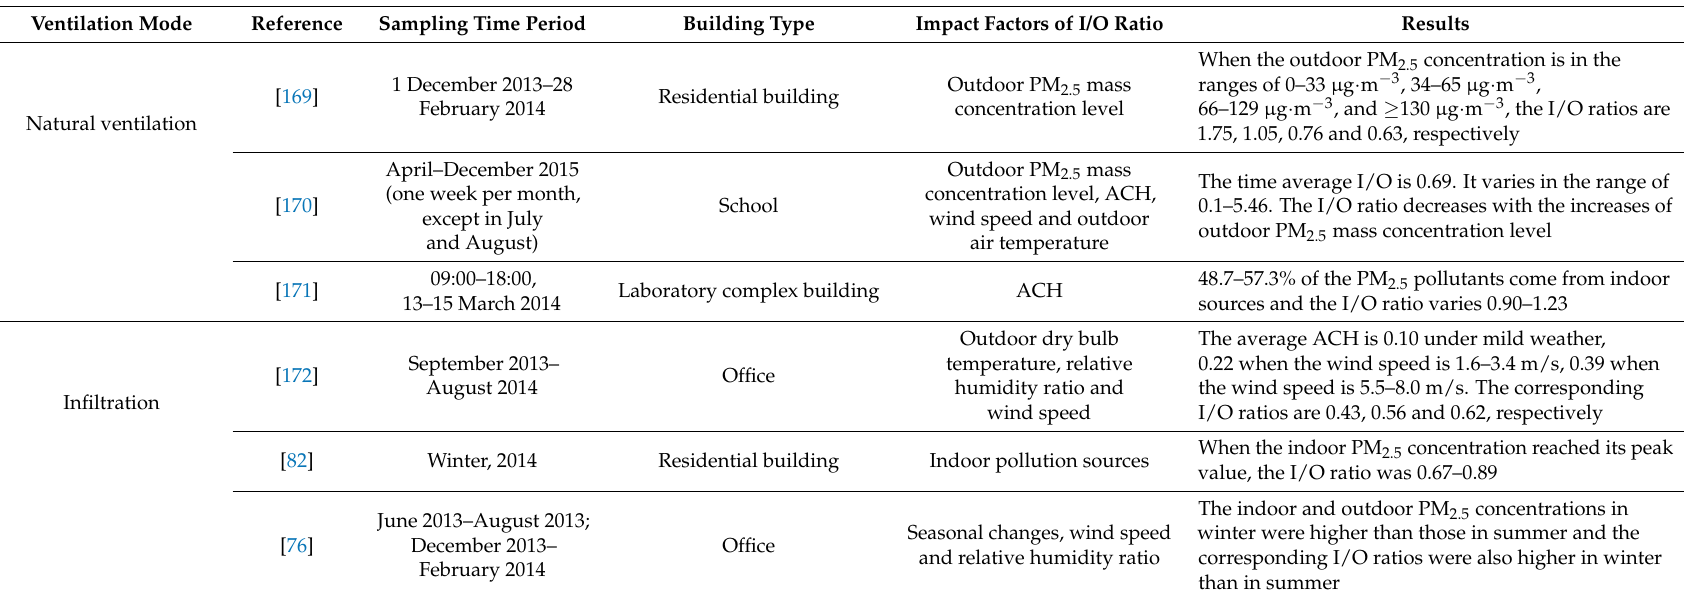
Table 4. I/O (indoor/outdoor) ratio under different ventilation